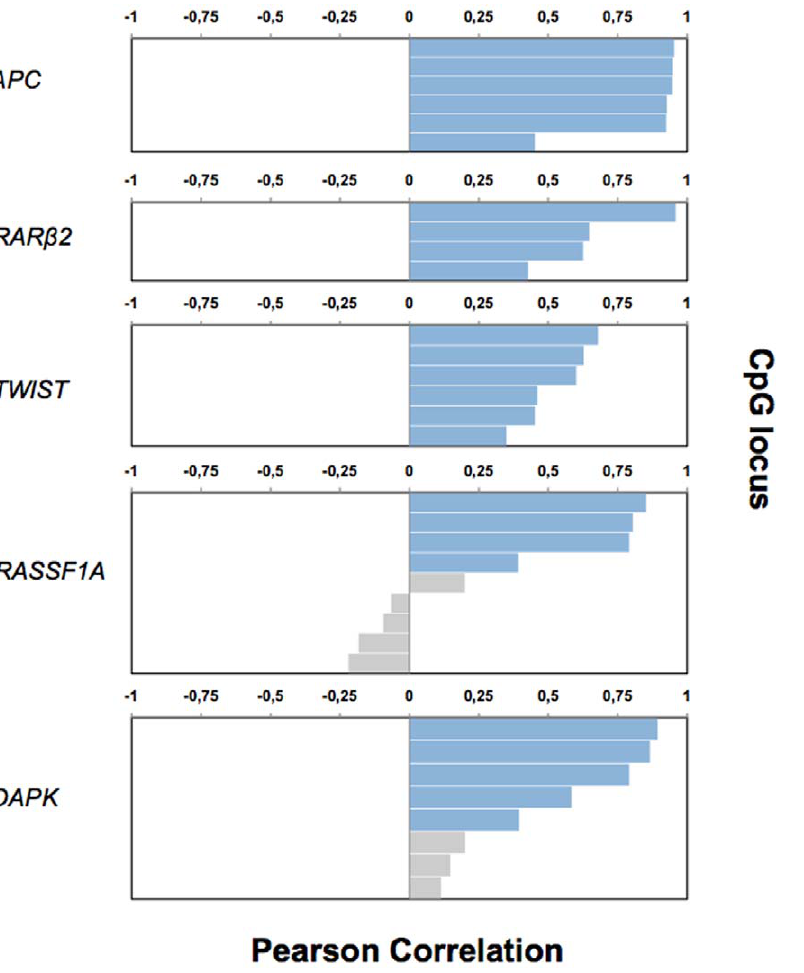
Figure 4. Analysis of correlation between methylation values from qMSP and the Infinium methylation array for five genes in 60 breast tumor samples. These five genes were represented by 33 CpG loci on the Infinium methylation array (y-axis). Pearson correlation values between methylation values from qMSP and the Infinium methylation array are shown on the x-axis, with negative values representing inverse correlations and positive values representing positive correlations. Significant correlation (P , 0.01) are indicated in blue.